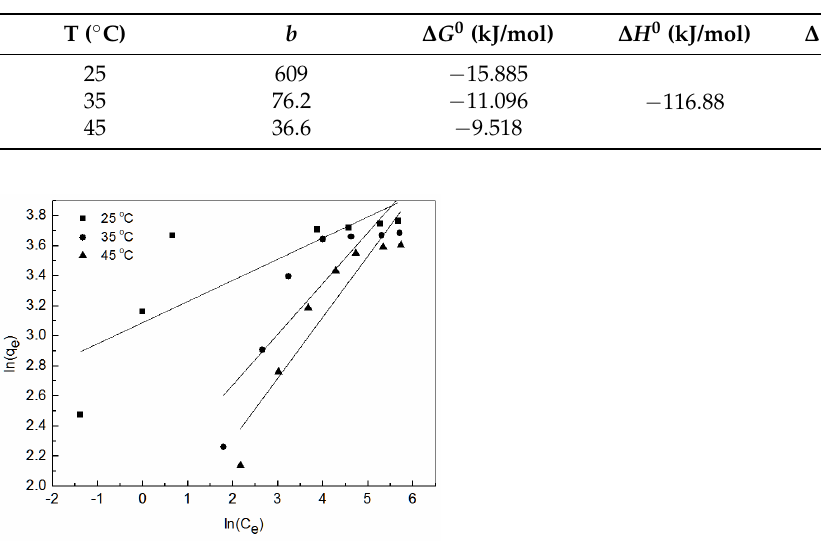
Table 4. Thermodynamic parameters for adsorption of Zn 2+ .